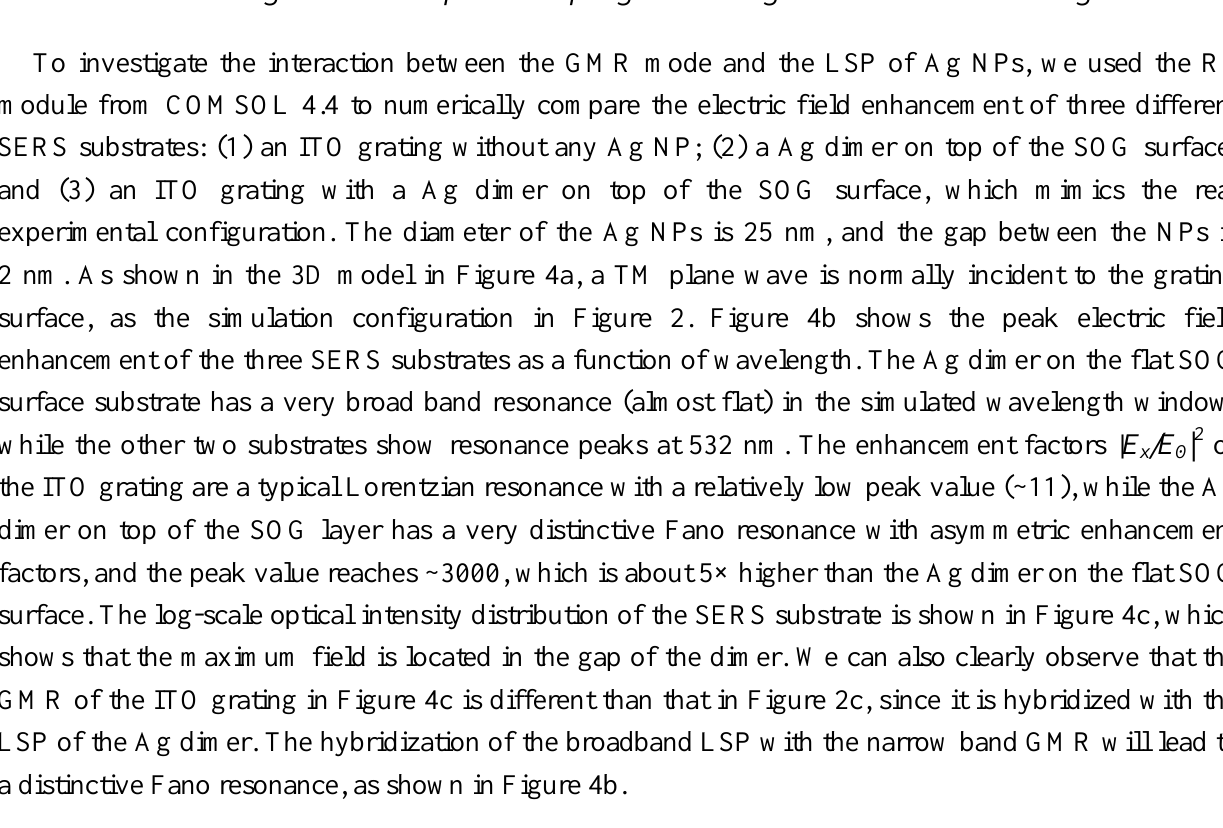
Figure 4. ( a ) 3D COMSOL model; ( b ) peak electric filed enhancement of three different surface-enhanced Raman scattering (SERS) substrates; ( c ) electric field distribution